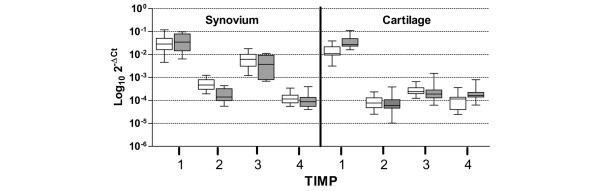
Comparative expression of TIMP genes in the fractured NOF (filled boxes) compared with OA (open boxes) hip synovium and cartilage. The expression level of each gene was determined, as described in Materials and methods, and normalized to the level of 18S rRNA gene expression using ΔCT [CT(target gene) – CT(18S)]. The box-and-whisker plot shows median values, and each section represents a quartile of the data.